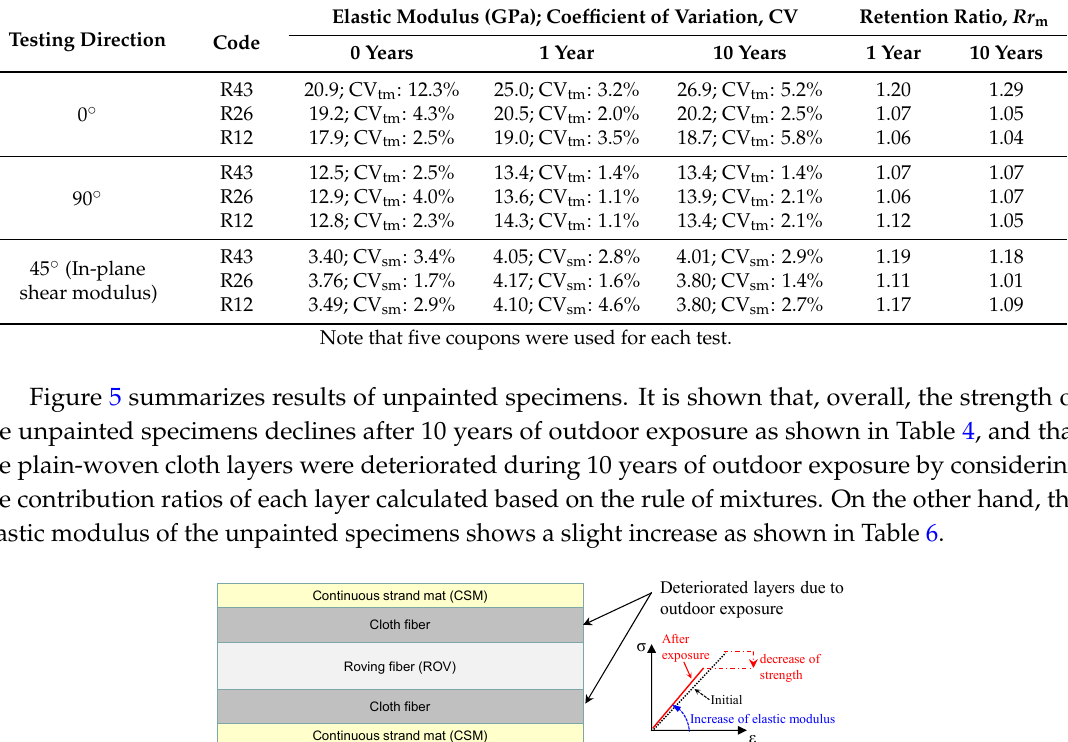
Table 6. Elastic modulus of unpainted specimens with retention ratios.